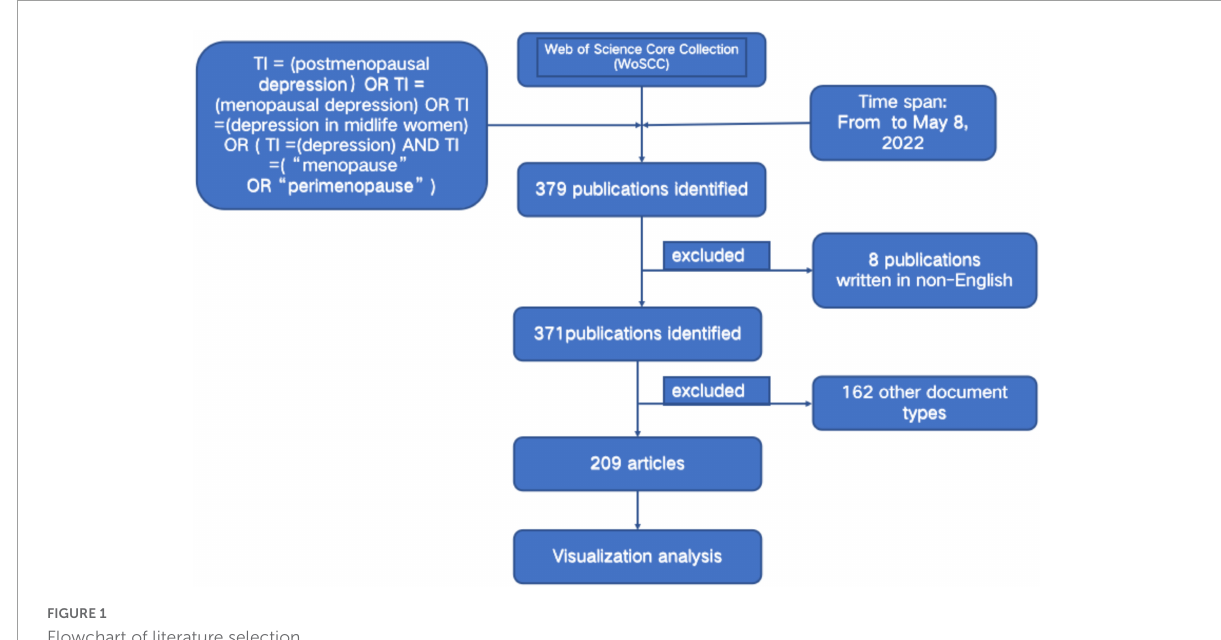
FIGURE1 Flowchart of literature selection.